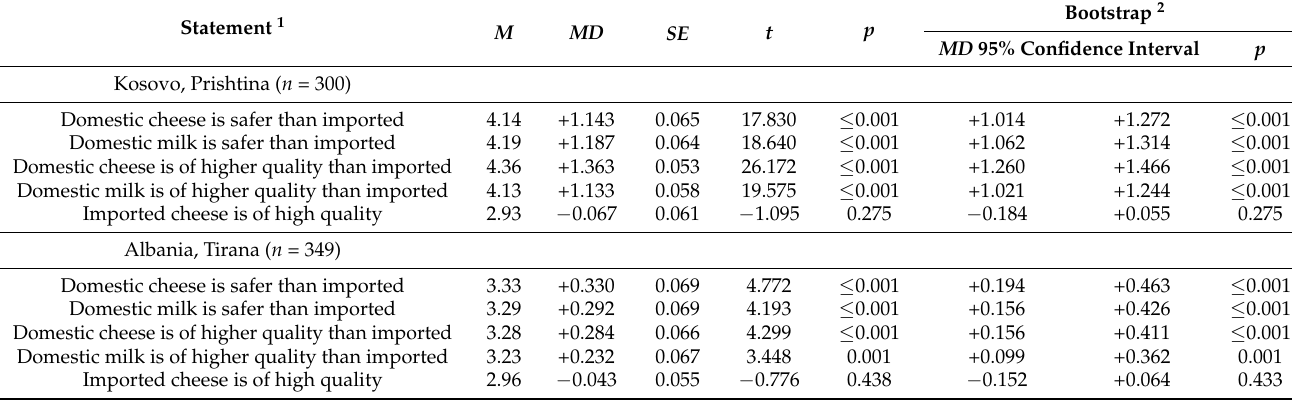
Table 3. Perception of domestic in comparison to imported dairy food in Kosovo (Prishtina) and Albania (Tirana); t -test including bootstrap sampling with test value = 3 (“neither agree nor disagree with